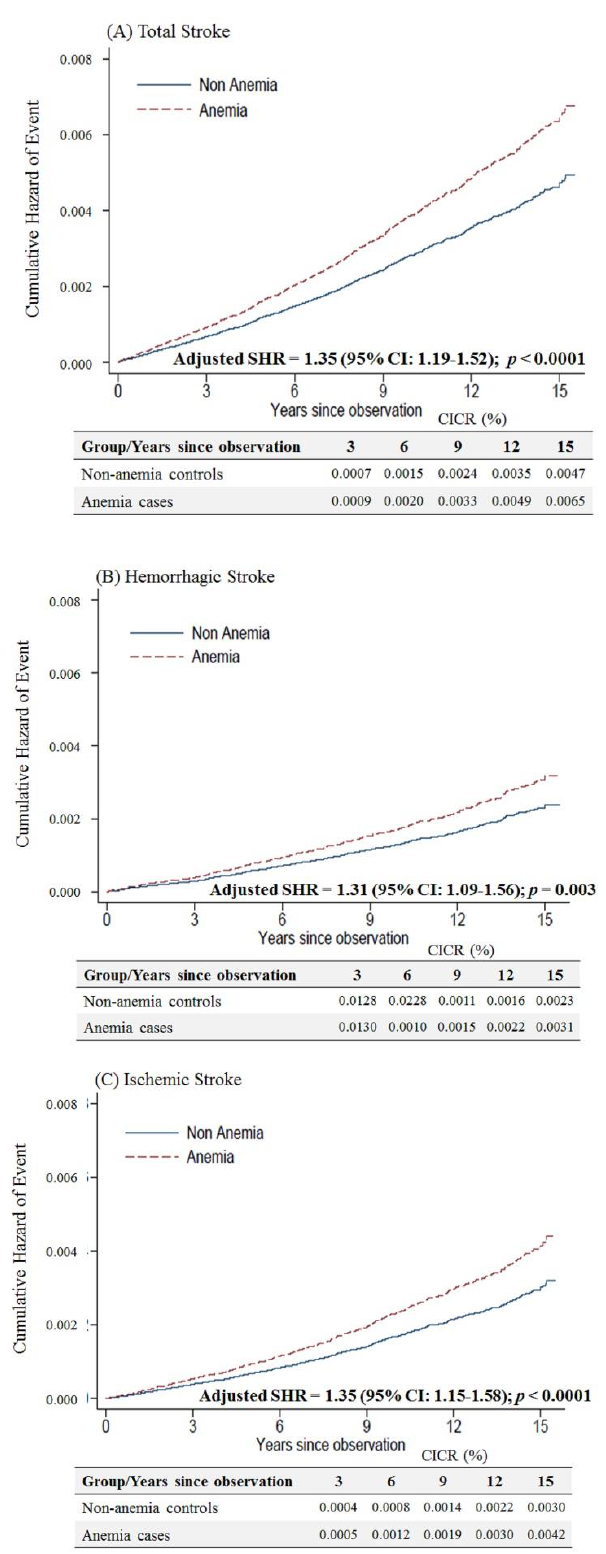
Figure 3. Cumulative incidences of competing risks (CICRs) of ( A ) total stroke, ( B ) hemorrhagic stroke and ( C ) ischemic stroke in anemia cases and non-anemia controls aged <50 years.